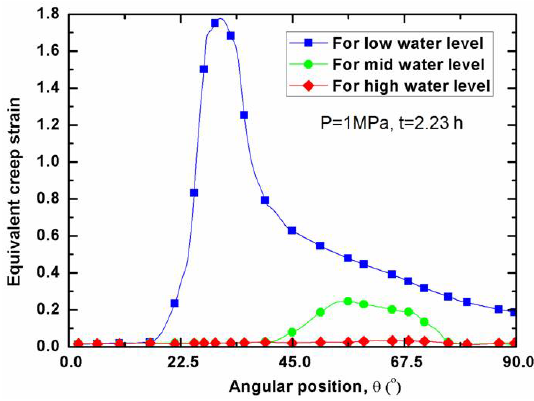
Figure 13. Comparison of creep distributions for RPV with various water levels under P = 1MPa.